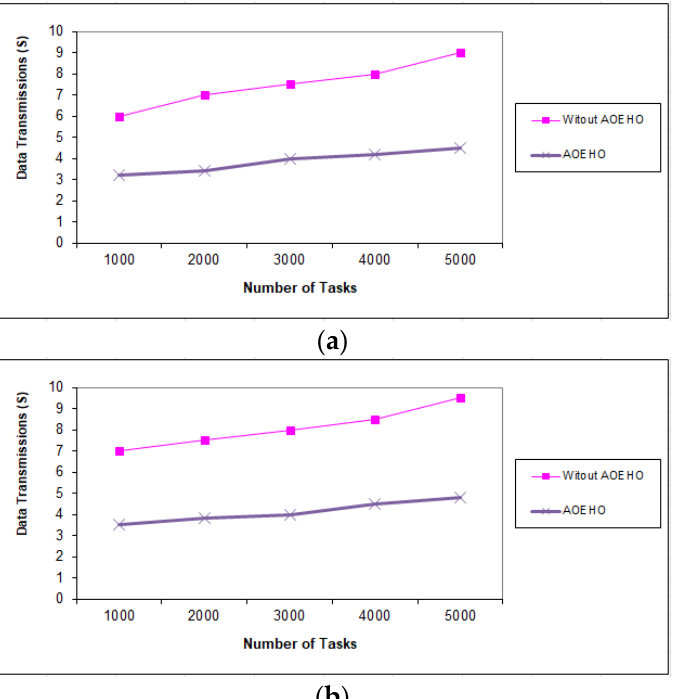
Figure 13. Data transmission between tasks = 5000 tasks. ( a ) Size of data replication = 64 MB. ( b ) Size of data replication = 320 MB.